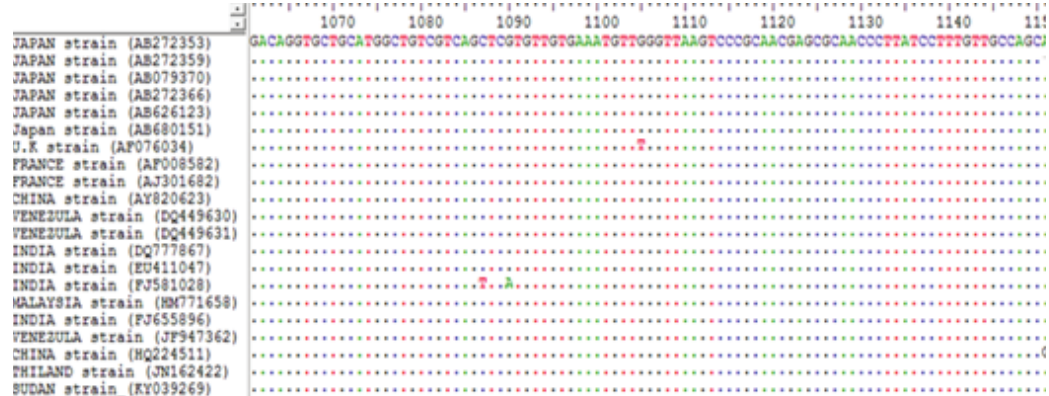
Figure 2: Multiple sequence alignment of 19 databases 16S rRNA genes with 16S rRNA gene of P. mirabilis isolate (KY 039269) from